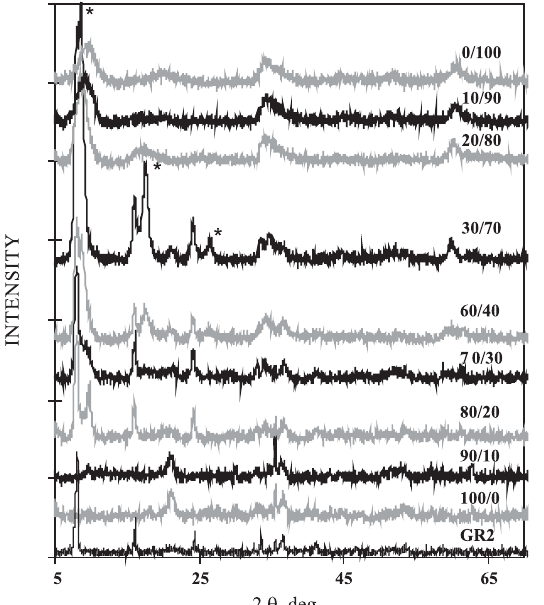
Figure 4. X ray diffraction patterns of the final products from the aerial oxidation of the dry Ni(II)-GR2 samples as a function of the Fe(II)/ Ni(II) ratio of the starting solution. Asterisks denote the peak positions for a second LDH with c-value 1.013 nm. Peaks for goethite (2 θθθθθ = 21°, 33°, 36.6°, 53.2°, 57.0°) and magnetite (2 θθθθθ = 30.1°, 35.5°, 36.6°, 53.2°, 57.0°, 62.7°) were identified for samples 100/0 and